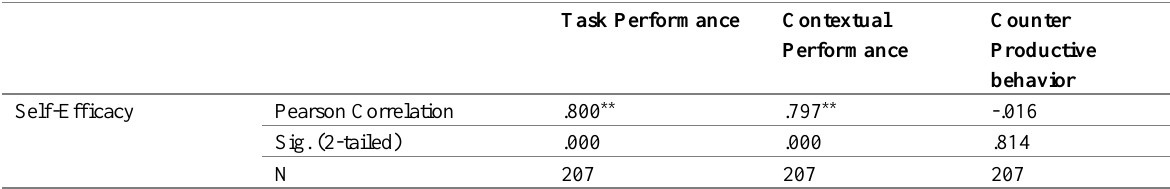
Table 10: Relationship between Self-efficacy and Individual Work Performance